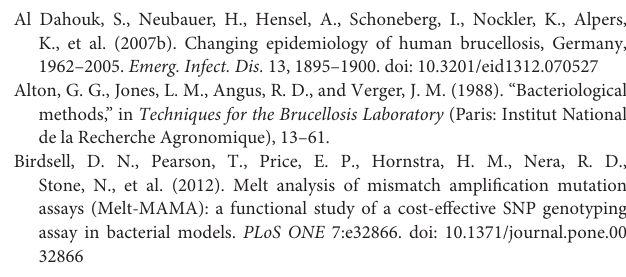
samples are part of the Americas clade. Moreover, Lounes et